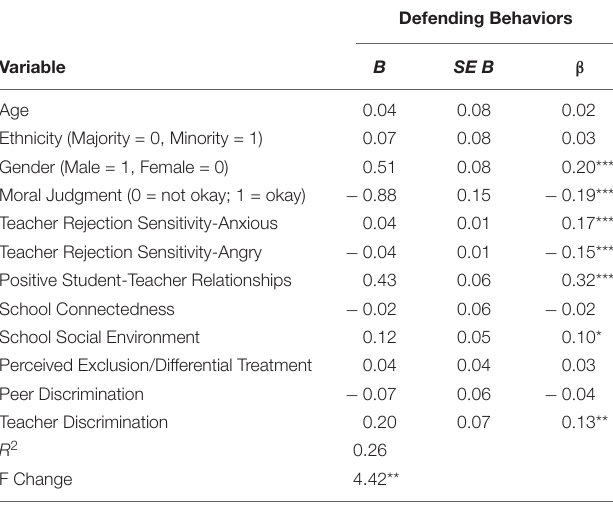
TABLE 3 | Bystander intervention in response to social exclusion: defending Moral Judgment